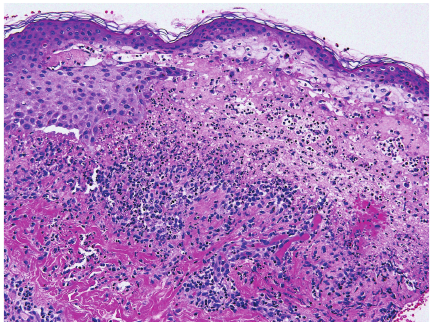
Figure 2: A higher power (20x) skin H&E image reveals abundant neutrophils and scattered eosinophils with a focal subepidermal split. Epidermal necrosis is again noted.